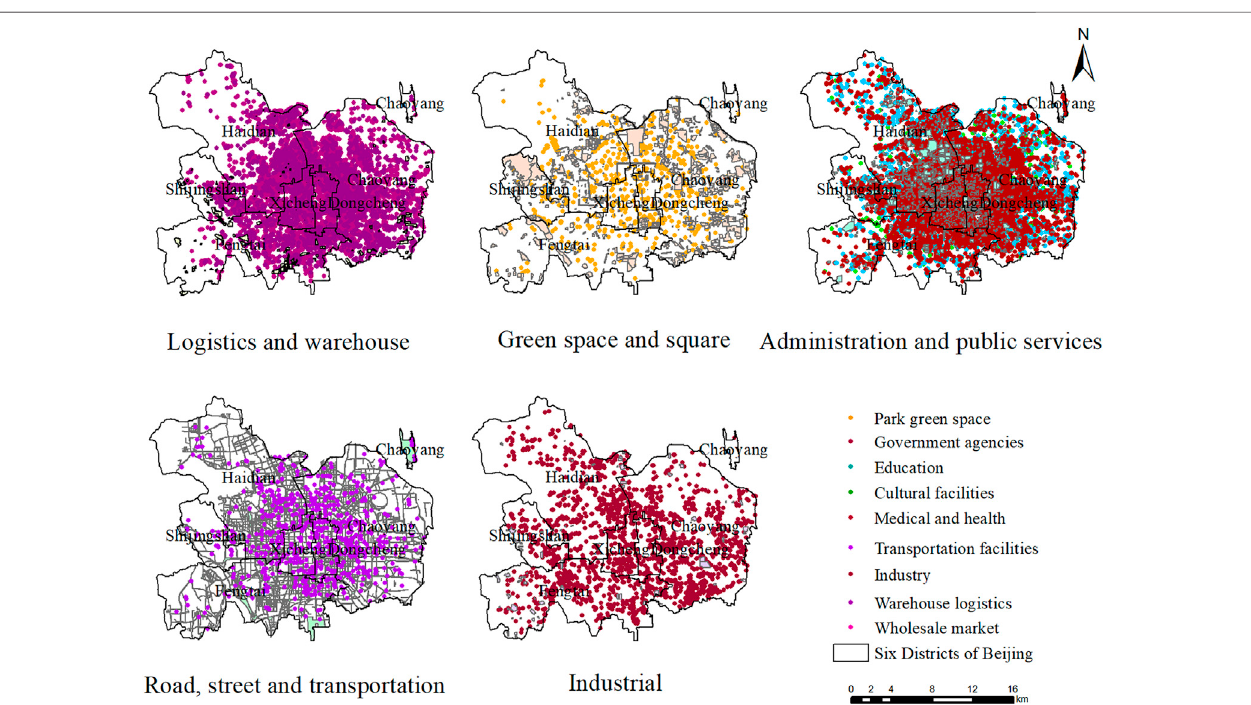
FIGURE 8 | Combination of various types of POI and land type interpretation maps in